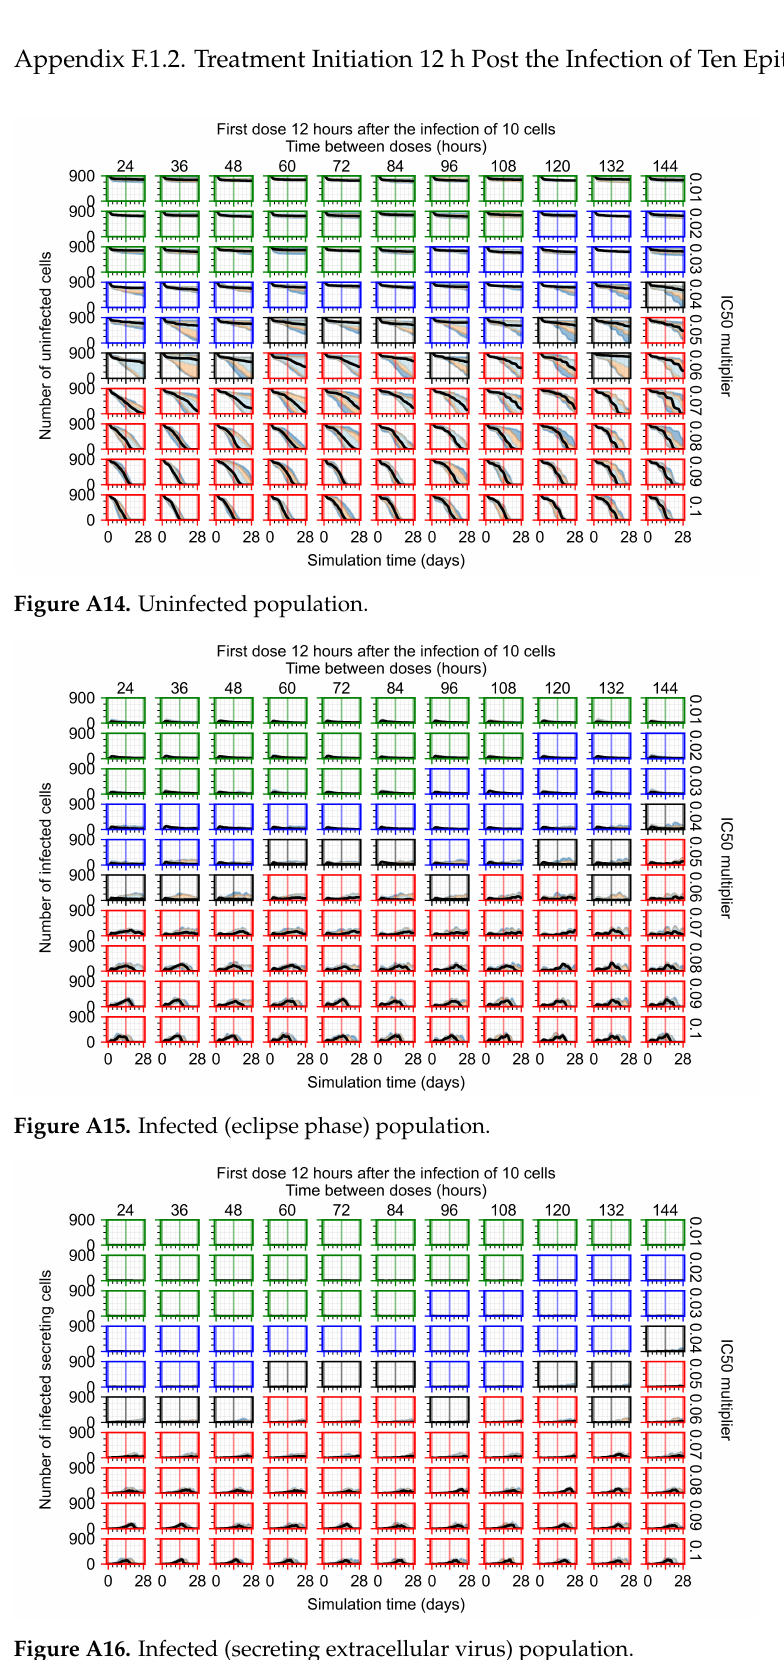
Figure A16. Infected (secreting extracellular virus)